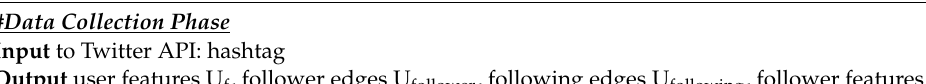
Algorithm 1: SEBD